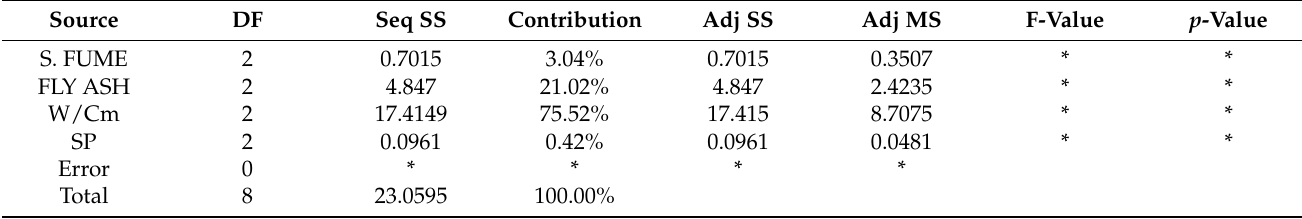
Table 9. ANOVA for FRC indirect tensile strength at 28